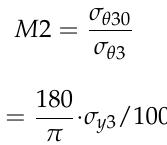
Table 4. Correction factors M2 used for the calculation of concentrations.